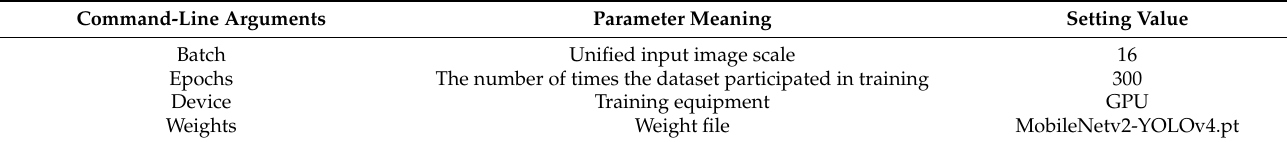
Table 7. Command-line parameter